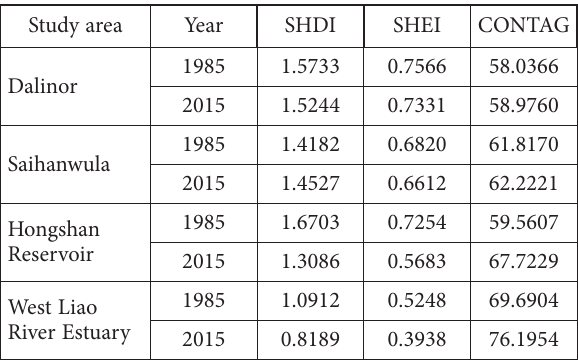
Table 8. Overall landscape pattern index of each study area Study